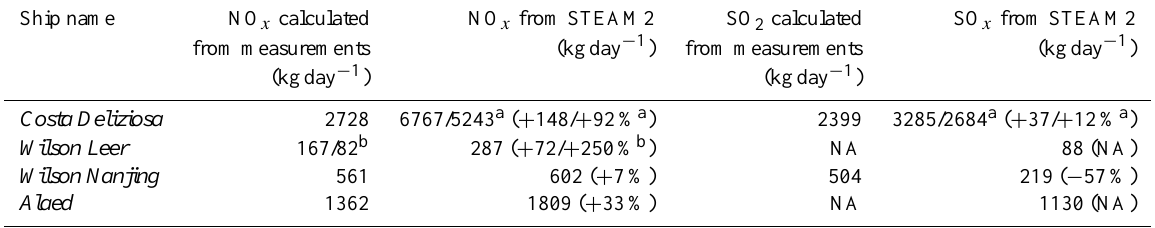
Table 4. NO x and SO 2 emissions estimated from FLEXPART-WRF and ACCESS measurements, compared with STEAM2 emissions. Values in parentheses indicate the relative difference between STEAM2 and calculated values. SO 2 emissions were not calculated for the Wilson Leer and Alaed since the measured SO 2 concentrations in the plumes were too low above